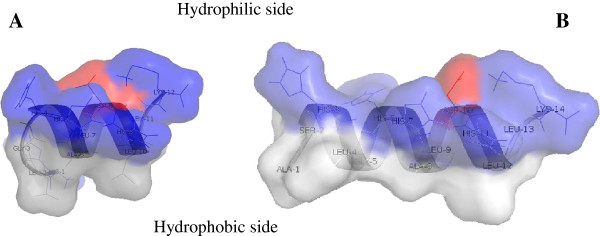
A ribbon representation of Holoturoidin 1 (A) and Holoturoidin 2 (B). The amphipathic nature of the peptide is shown in this representation with the hydrophilic side above and the hydrophobic side below the polypeptide backbone. The potential surface is superimposed. Color code: acidic residues in red, basic residues in blue, and hydrophobic residues in white.